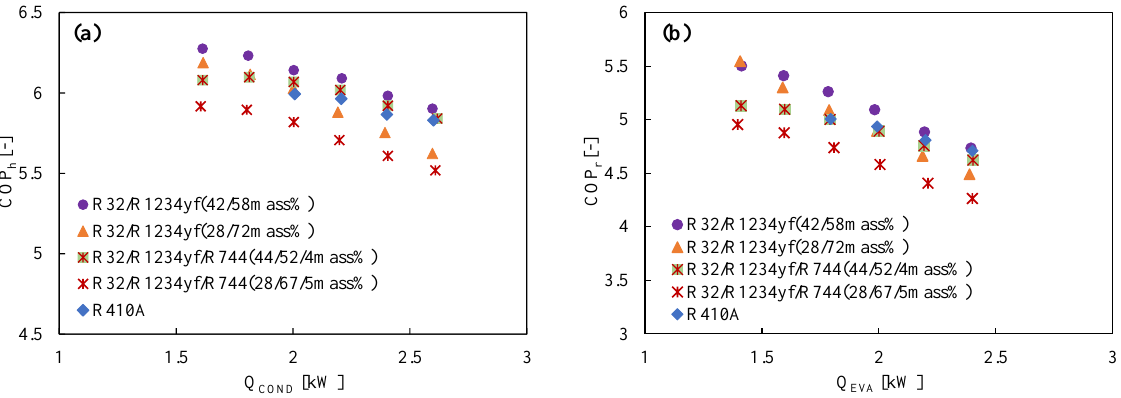
Figure 12. Variation of the COP with heating and cooling load for R1234ze(E)-based binary and ternary mixtures in a drop-in experiment at the optimum charged condition in ( a ) the heating mode and ( b ) the cooling mode [134].